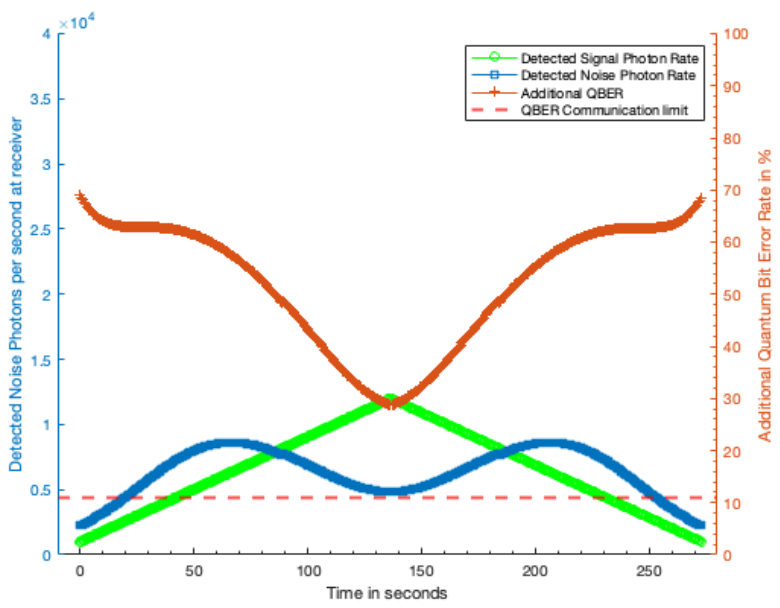
Figure 8. Additional QBER generated from two symmetrically placed 1 kW laser terminals both 1000 km from the receiving station so that one overlaps the early and the other the late part of the transmission window. At no point during the transmission window from the Satellite is any secure key generated as the additional QBER always exceeds 11%. Green trace, detected QKD signal photon rate; blue trace, detected excess noise photon rate; red trace, additional QBER due to excess noise photons; dashed red line, QBER limit at which no secure key can be